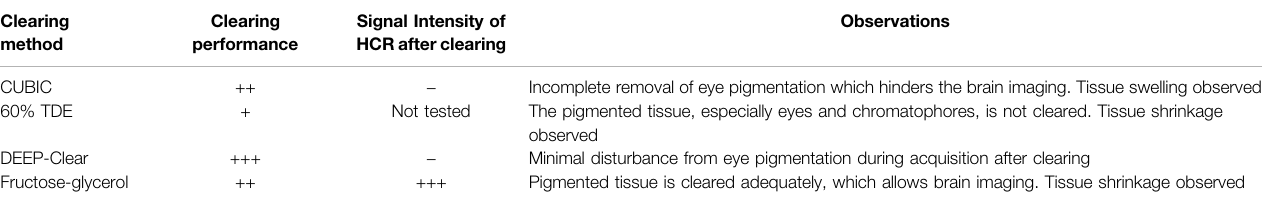
TABLE 1 | Comparison of different water-based clearing methods and their compatibility with HCR on whole mount octopus embryos and paralarvae. Clearing Clearing Signal Intensity of method performance HCRafterclearing